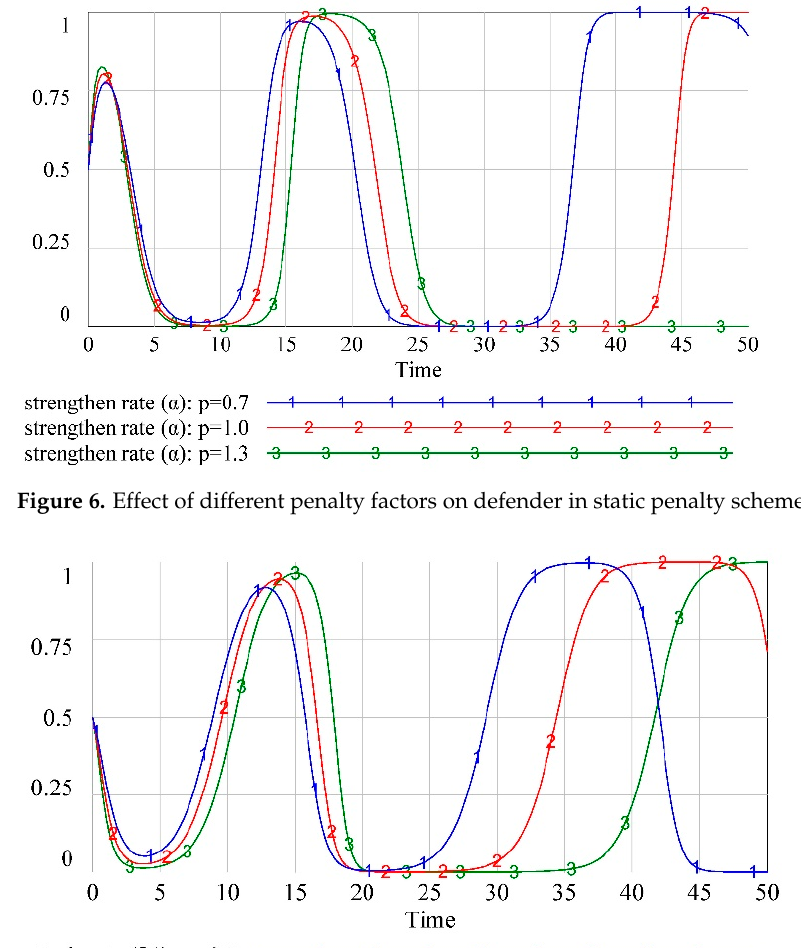
β 1 = 0.5, β 2 = 0.5. The strategy choices of the defender and attacker (1) under different penalty strengths are shown in Figures 6 and 7.